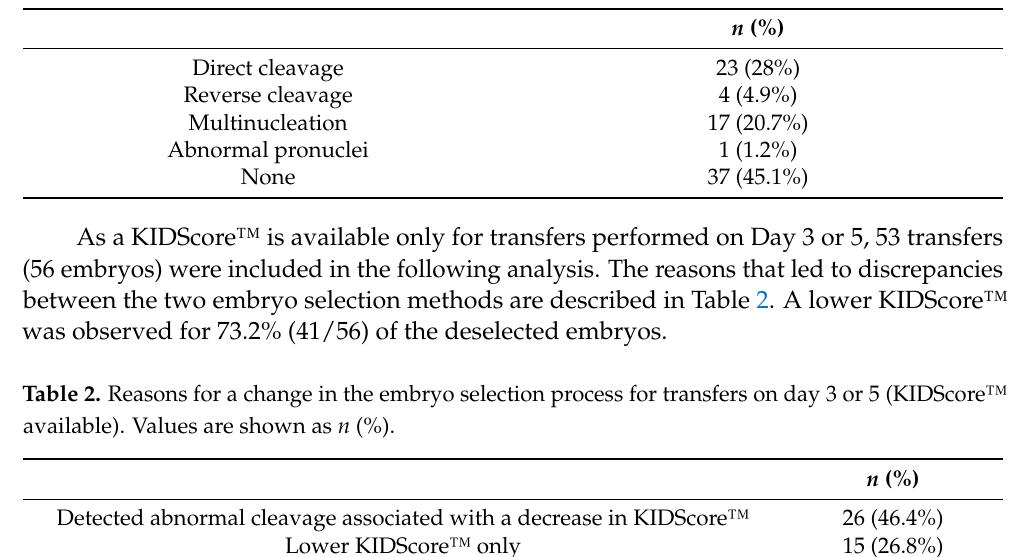
Table 1. Types of anomalies detected with TLS for deselected embryos. Values are shown as n (%).